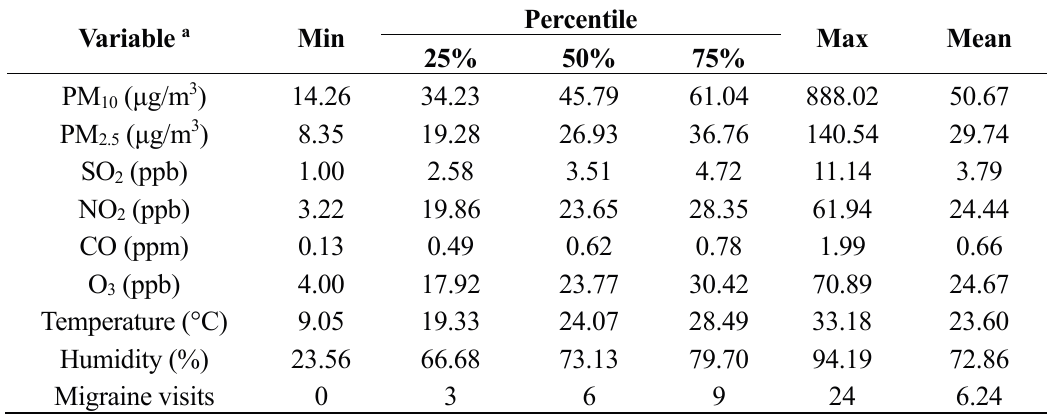
Table 1. Distribution of daily clinic visits, weather, and air pollution variables in Taipei, Taiwan, 2006–2011.